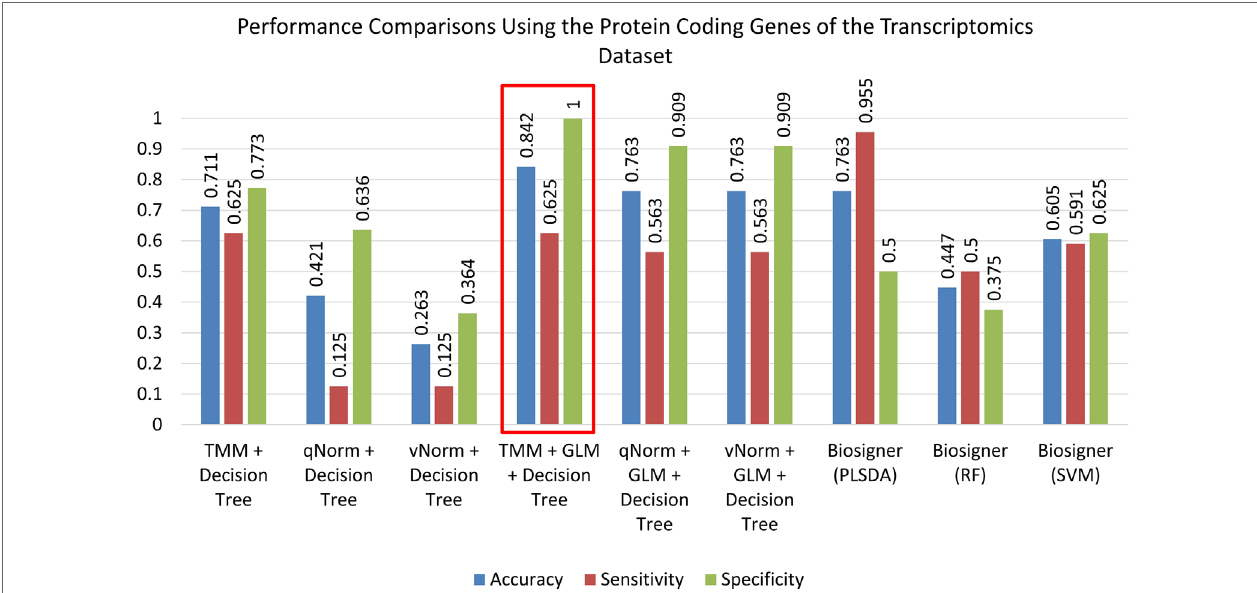
FIGURE 4 | Performance comparisons using the protein-coding genes of the transcriptomics